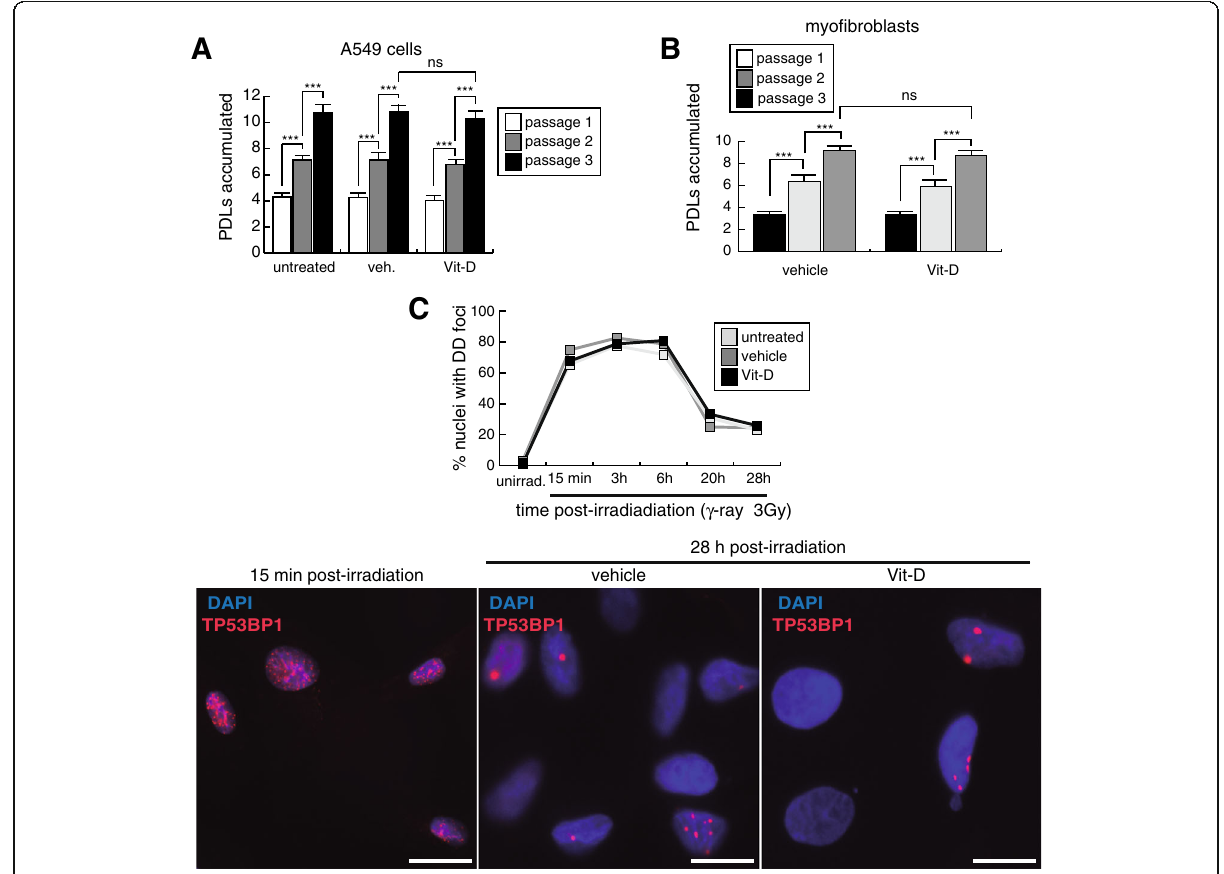
Fig. 2 Results related to serial cell passages and γ -ray radiations. a Accumulation of population doubling levels during three passages of A549 cells treated with 5 nmol/L vitamin D or its vehicle. b Accumulation of population doubling levels during three passages of myofibroblasts treated with 5 nmol/L vitamin D or its vehicle. c Kinetics of DNA repair of DSBs induced by γ -radiation (3Gy). A549 cells were treated with 5 nmol/ L vitamin D or its vehicle 2 h before irradiations and then subjected to 3Gy of γ -ray. At different times post-irradiation, cells were processed for indirect immunofluorescence of TP53BP1 to detect DSBs. DNA DD foci were quantified from representative micrographs (more than 150 cells examined). Bottom pictures show representative micrographs of the kinetics at 15 min and 28 h